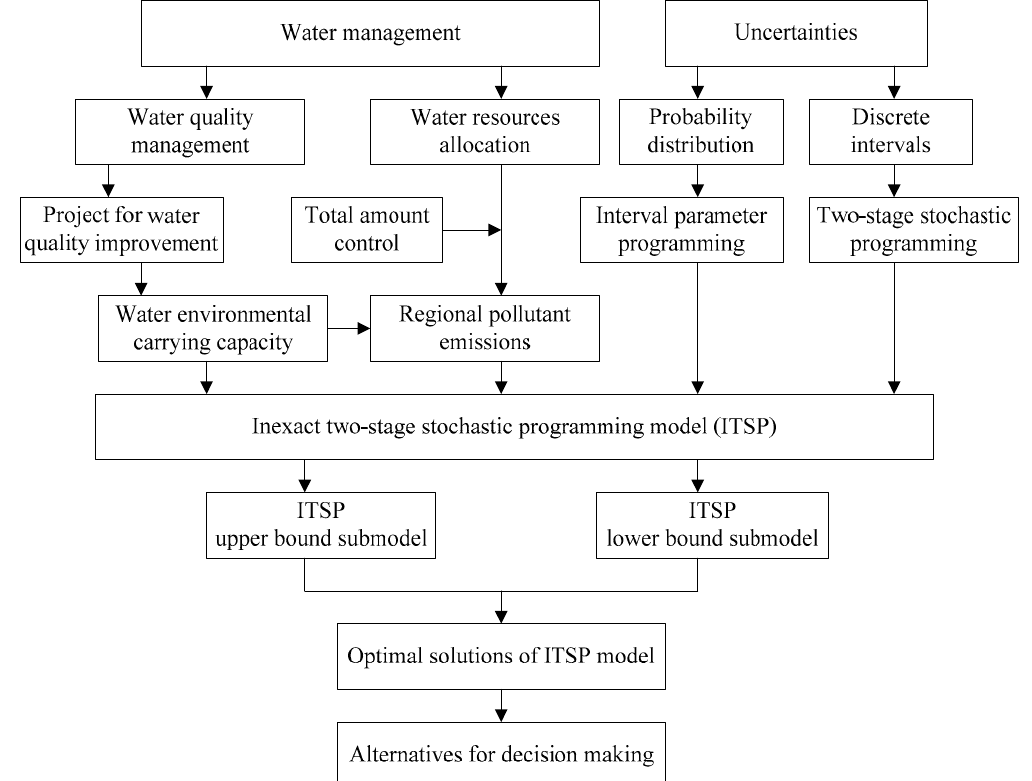
Figure 1. Framework for the inexact two-stage stochastic programming (ITSP) model.